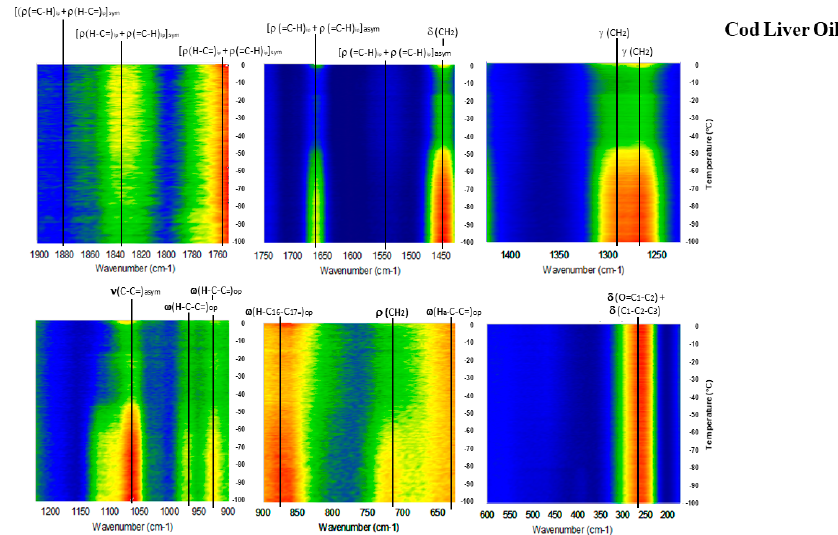
Figure 8. GTRS contour plot, Arctic cod liver oil (CLO). Note, major Raman mode intensity changes and discontinuities that correlate with heat flow data in Figure 5.